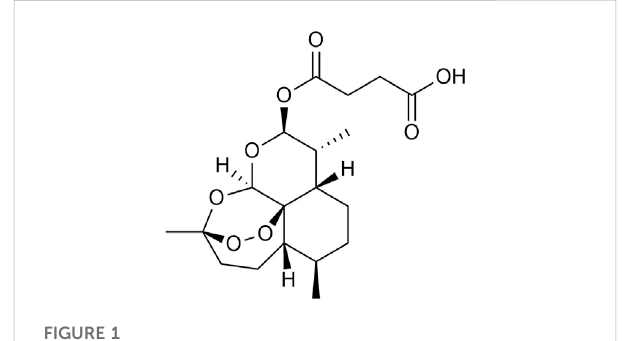
FIGURE 1 Chemical structure of Artesunate.